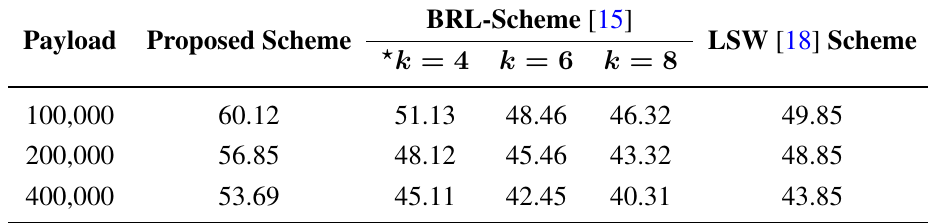
Table 5. Comparison of the PSNR values using binary image to hiding with different